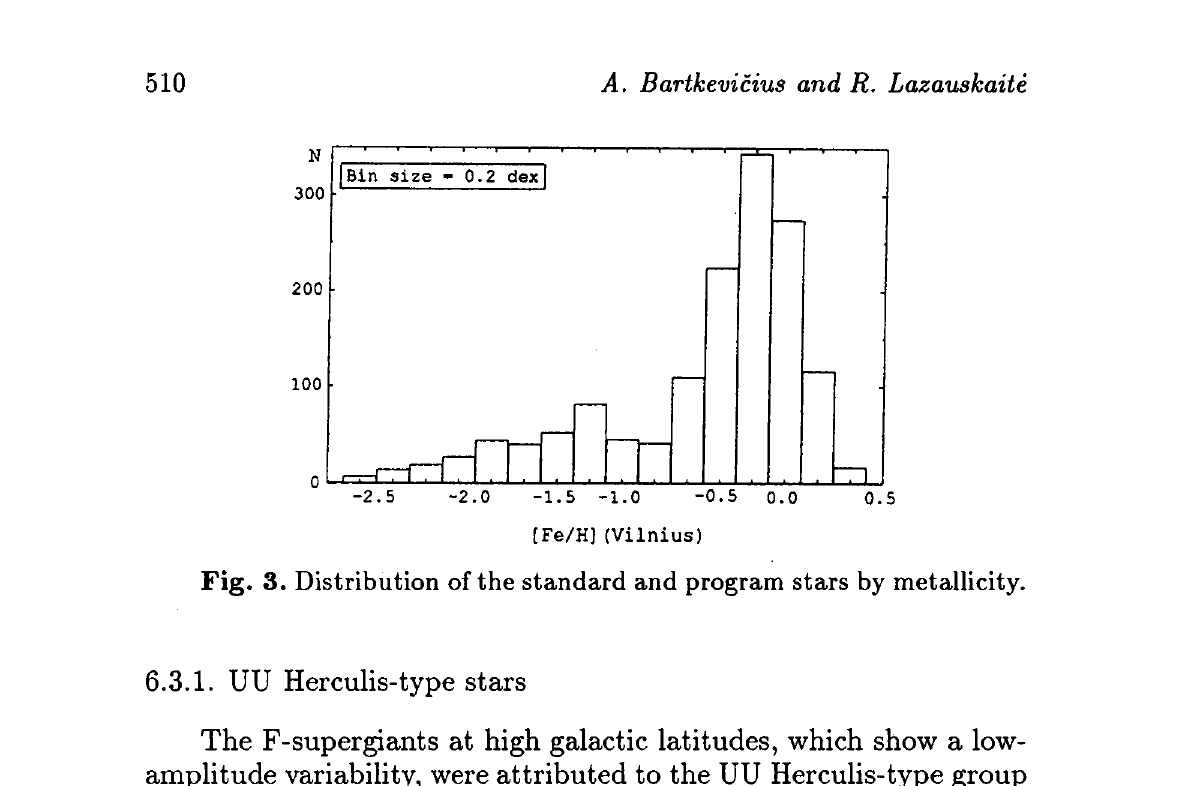
Fig. 3. Distribution of the standard and program stars by